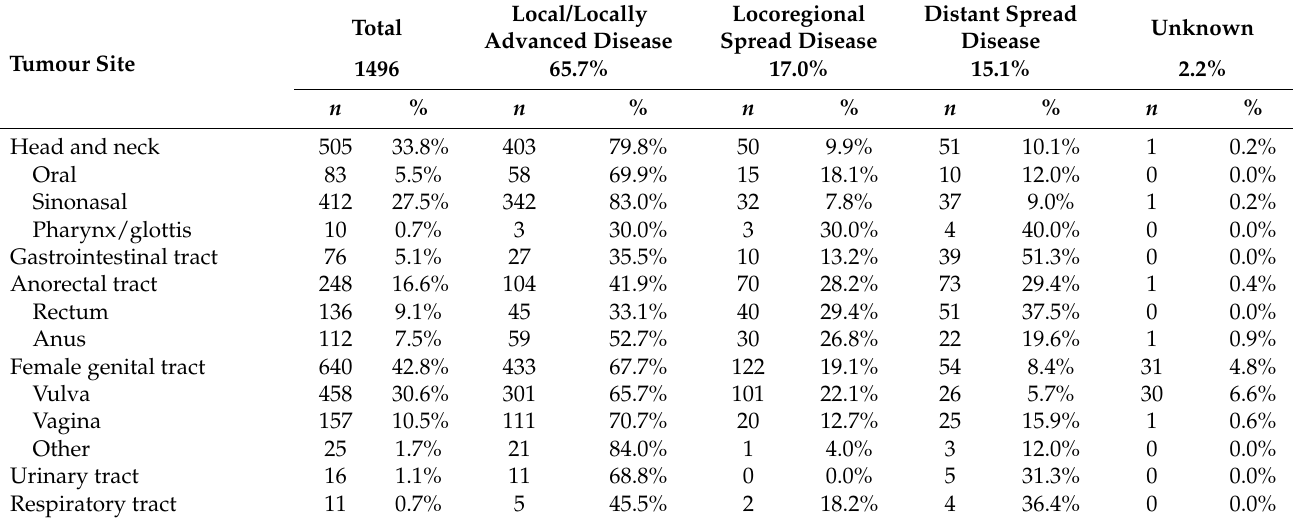
Table 2. Distribution of tumour stage by site of mucosal